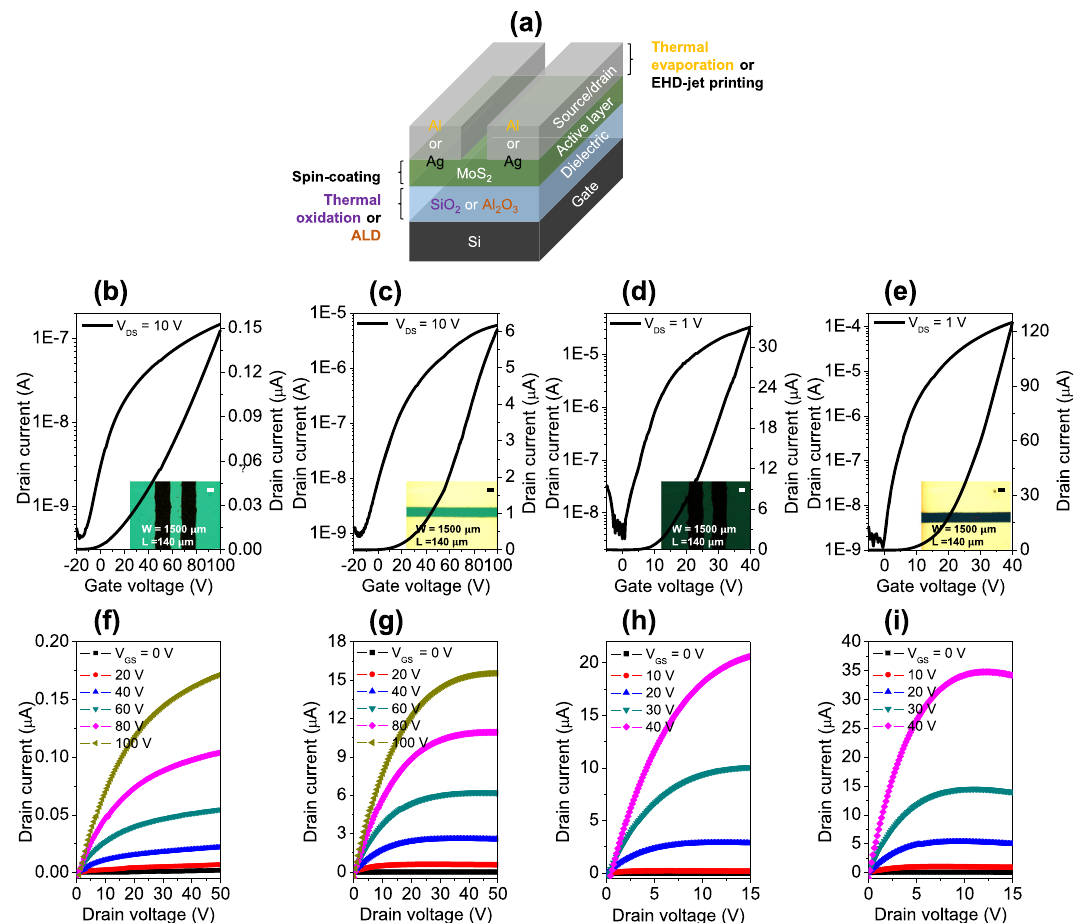
Fig. 6 Schematic and electrical properties of MoS 2 TFTs. a Schematic and the composition of MoS 2 TFTs with layer roles and deposition methods of four groups. b – e Typical transfer characteristics and f – i output curves of TFTs from groups A, B, C, and D, respectively. The inset of b – e shows optical image of a representative TFT for each group (scale bar: 100 μ m).